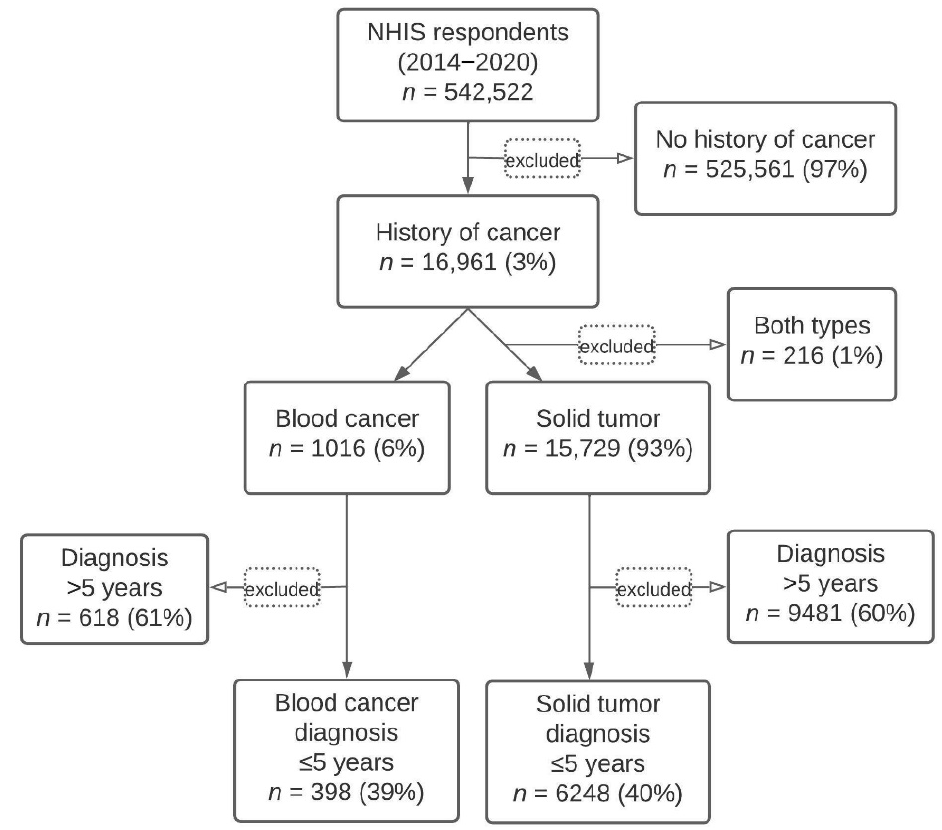
Figure 1. NHIS cohort identification.